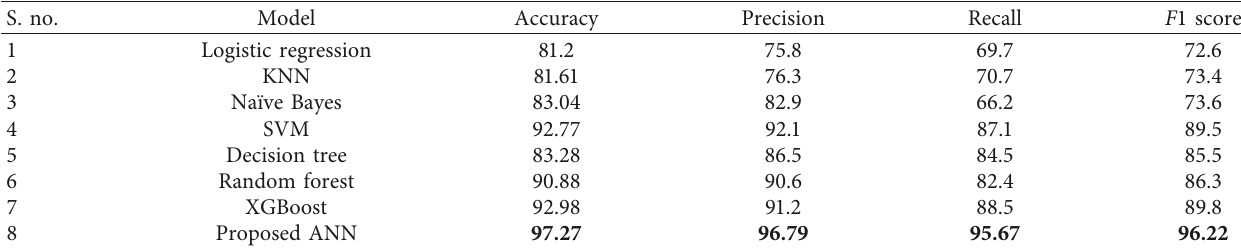
Table 4: Performance parameters for prediction models.